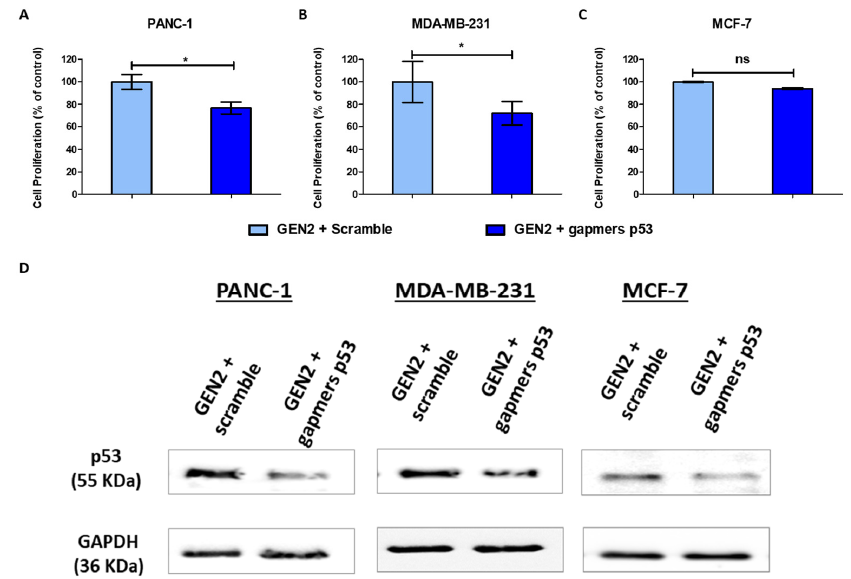
Figure 4. Modified gold nanoparticles reduce mutant p53 cancer cell proliferation. ( A – C ) The cells lines were seeded in 96-well plates, incubated overnight, and treated with GEN2-AuNPs functionalized with gapmers against p53. After 72 h, their viability was assessed. ( D ) Whole-cell extracts were processed for Western blot analysis of the indicated antibodies. GAPDH protein level in the same extract was used as a control loading. Statistical analysis was performed using one-way ANOVA (each group vs. control, * p < 0.05).